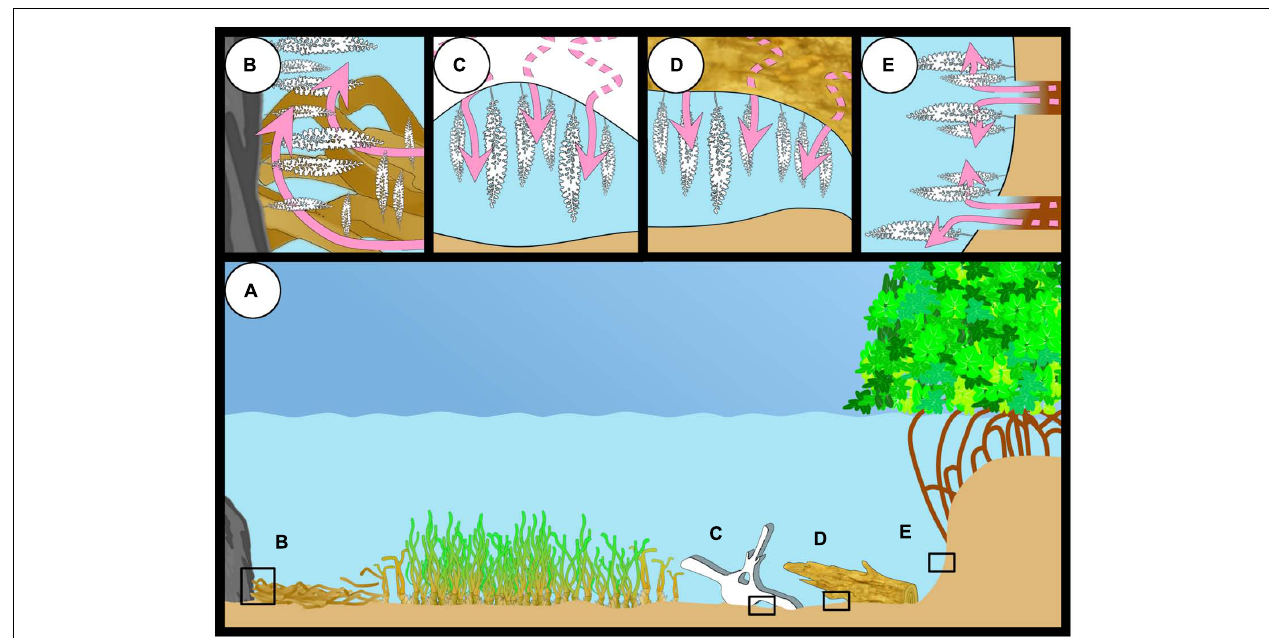
FIGURE 8 | The different habitats of Zoothamnium niveum (A). The giant ciliate can colonize hard substrate close to sea grass debris accumulation where sulfide (pink arrows) is produced or grow directly on the sea grass debris itself (B) . They have also been